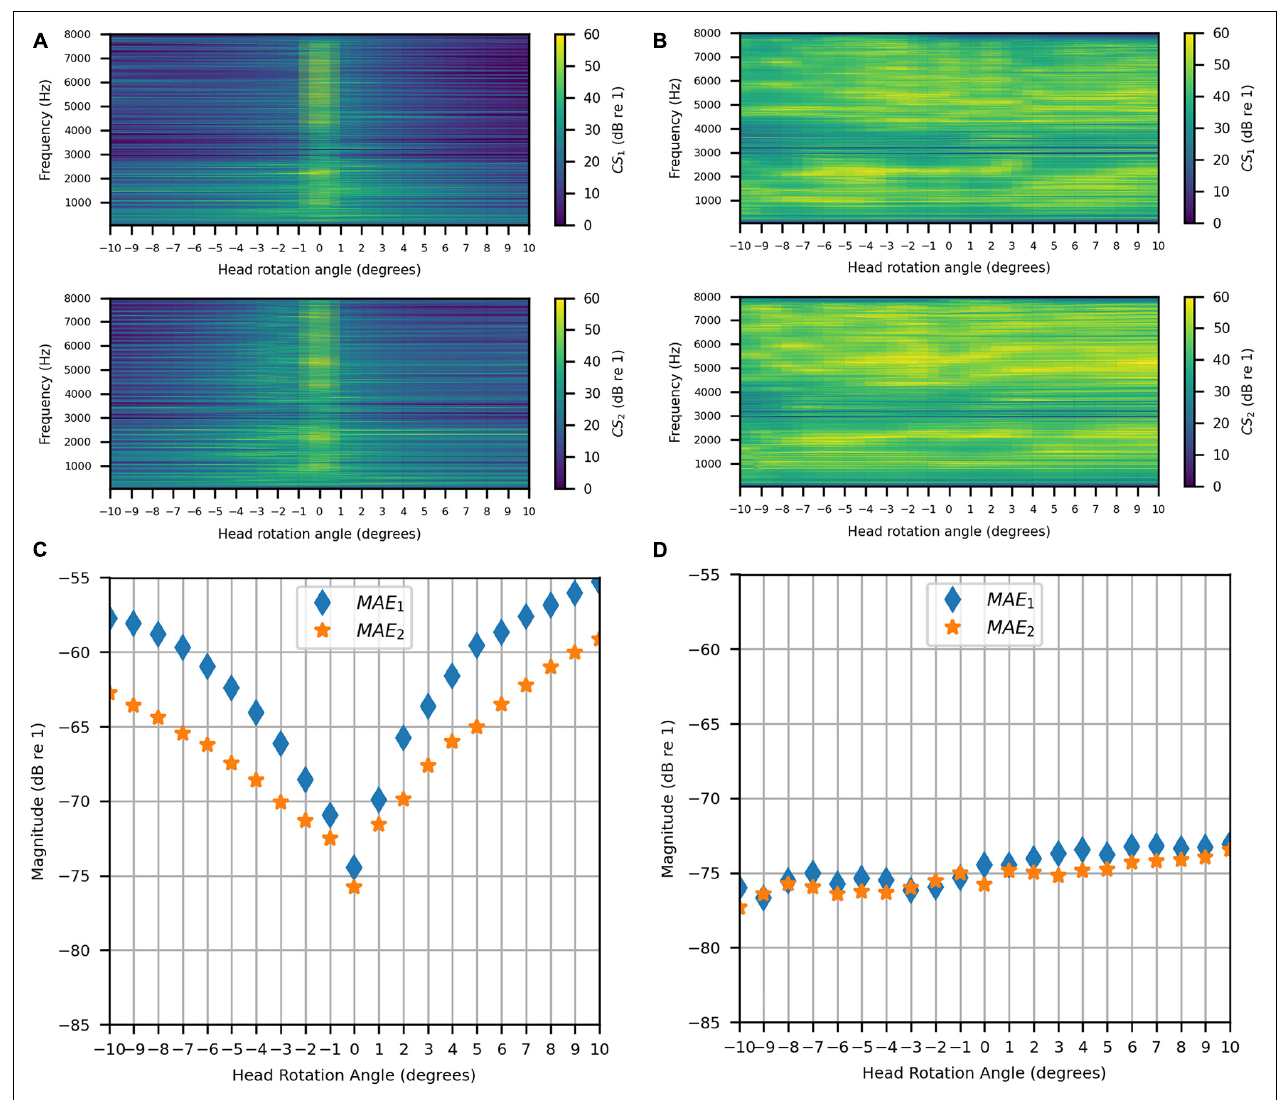
FIGURE 15 | Clinical Booth: (A) Uncompensated channel separation as a function of frequency in Hz and head rotation angle; (B) Compensated channel separation as a function of frequency in Hz and head rotation angle; (C) Uncompensated mean absolute errors as functions of head rotation angle; (D) Compensated mean absolute errors as functions of head rotation